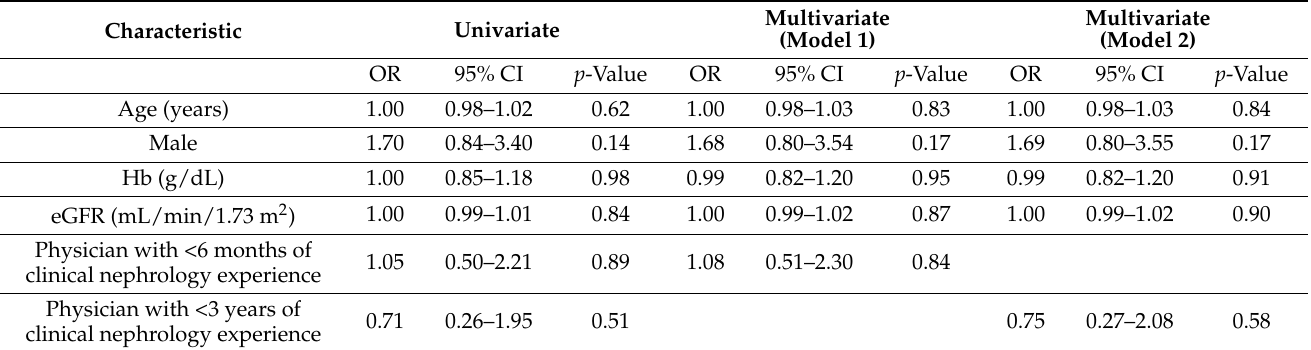
Table 4. Logistic regression analysis for risk of composite complication after renal biopsy.